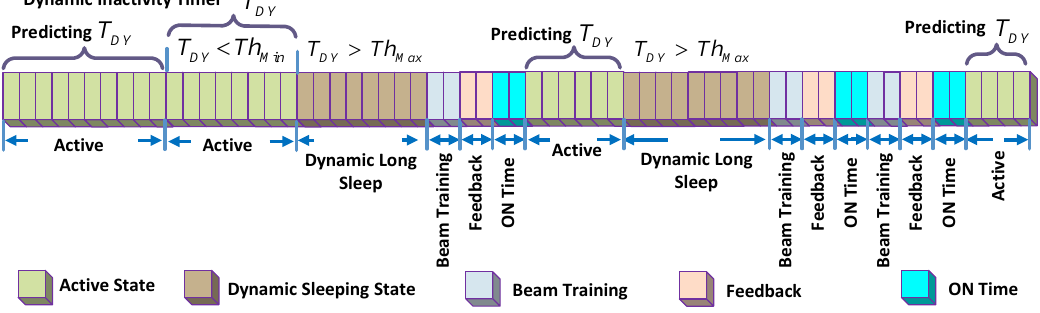
Figure 7. Timing diagram of AI-DRX based dynamic long sleep